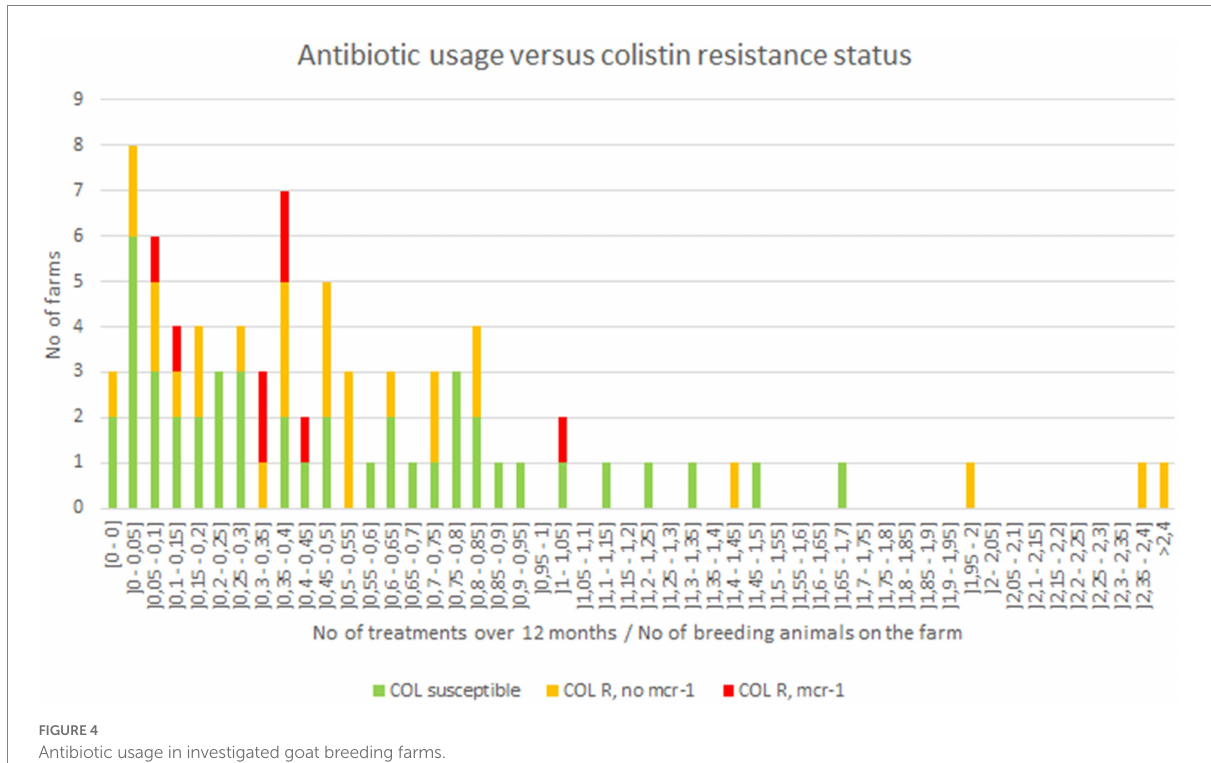
FIGURE 4 Antibiotic usage in investigated goat breeding